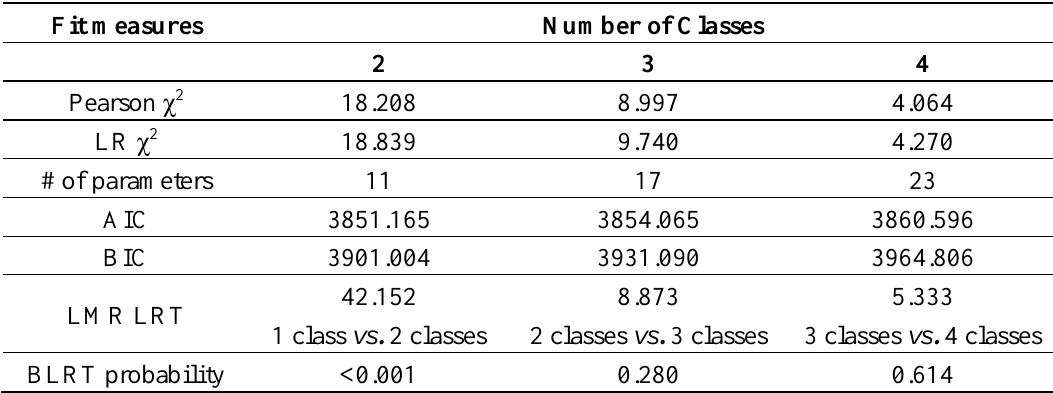
Table 3. Criteria used to identify the best number of latent classes.